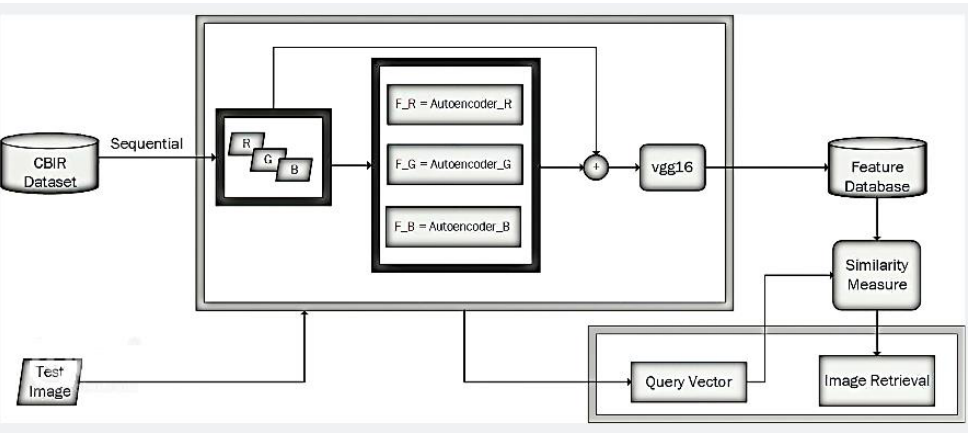
Figure 1. Architecture of the proposed RIS-DUGL retrieval model.